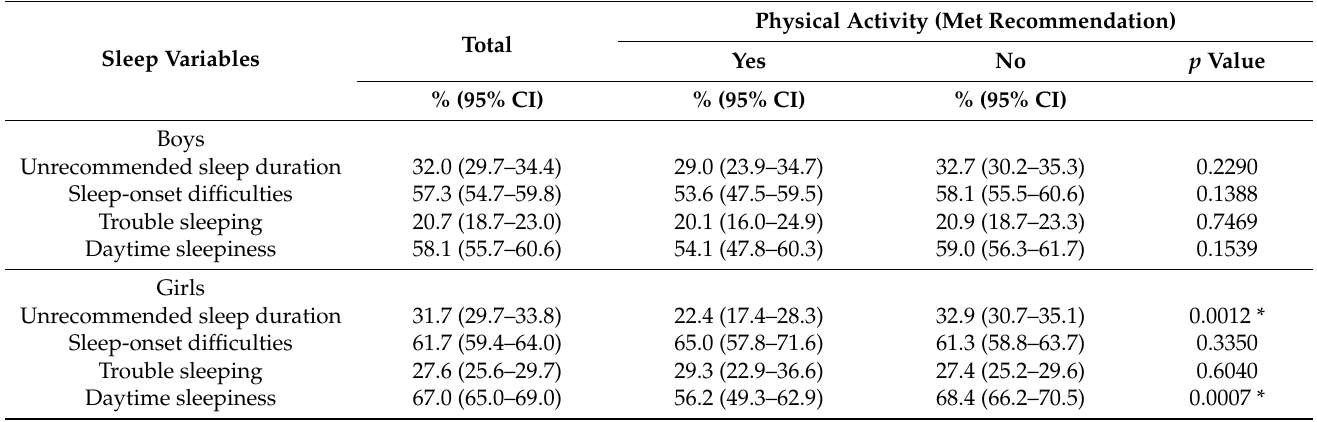
Table 2. Sleep difficulties in adolescent girls and boys stratified by physical activity (met